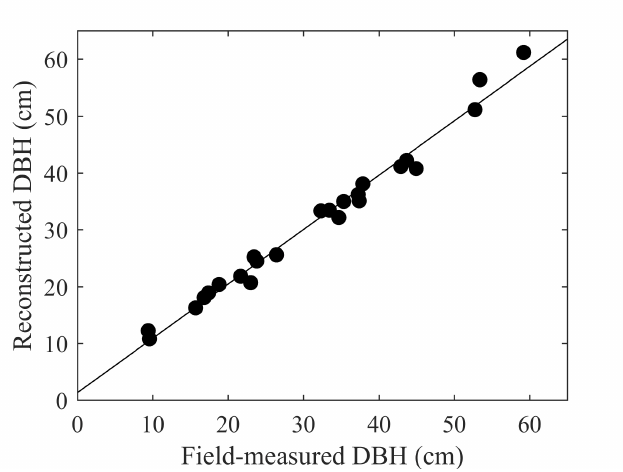
Figure 10. Scatter plot of DBH automatically estimated from TLS and reference measurements in the field. The R 2 is